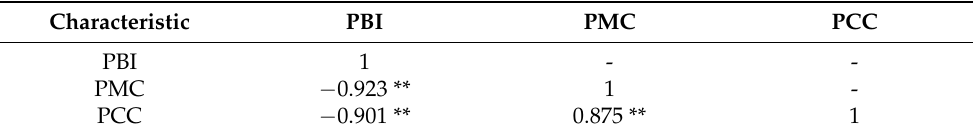
Table 6. Correlations between Peduncle Browning Incidence (PBI), Peduncle Moisture Content (PMC), and Peduncle Chlorophyll Content